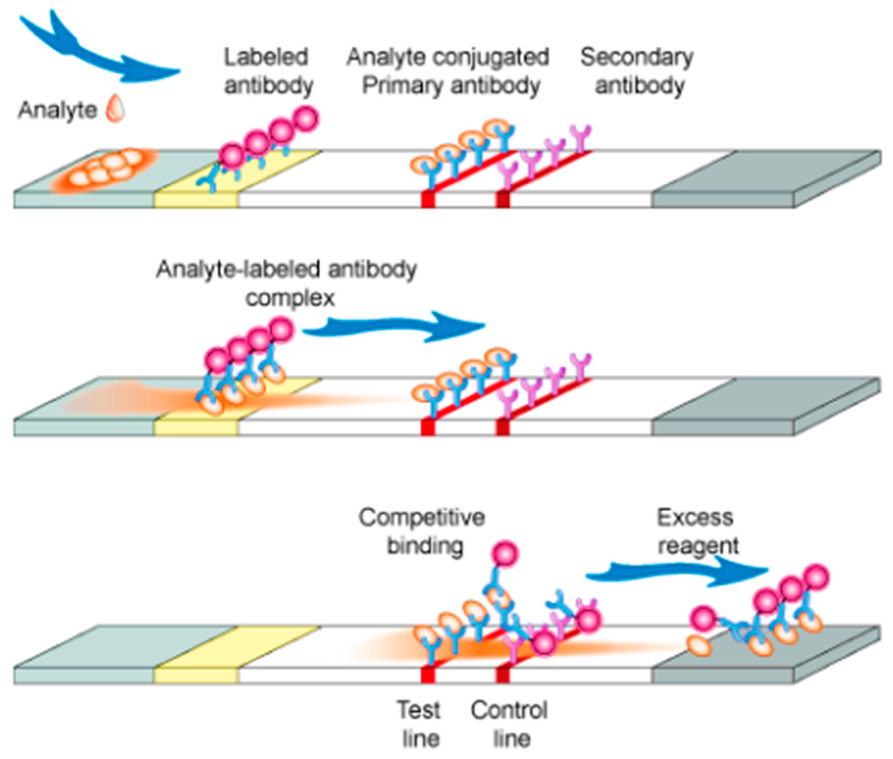
Figure 4. Competitive immunochromatographic test [84].